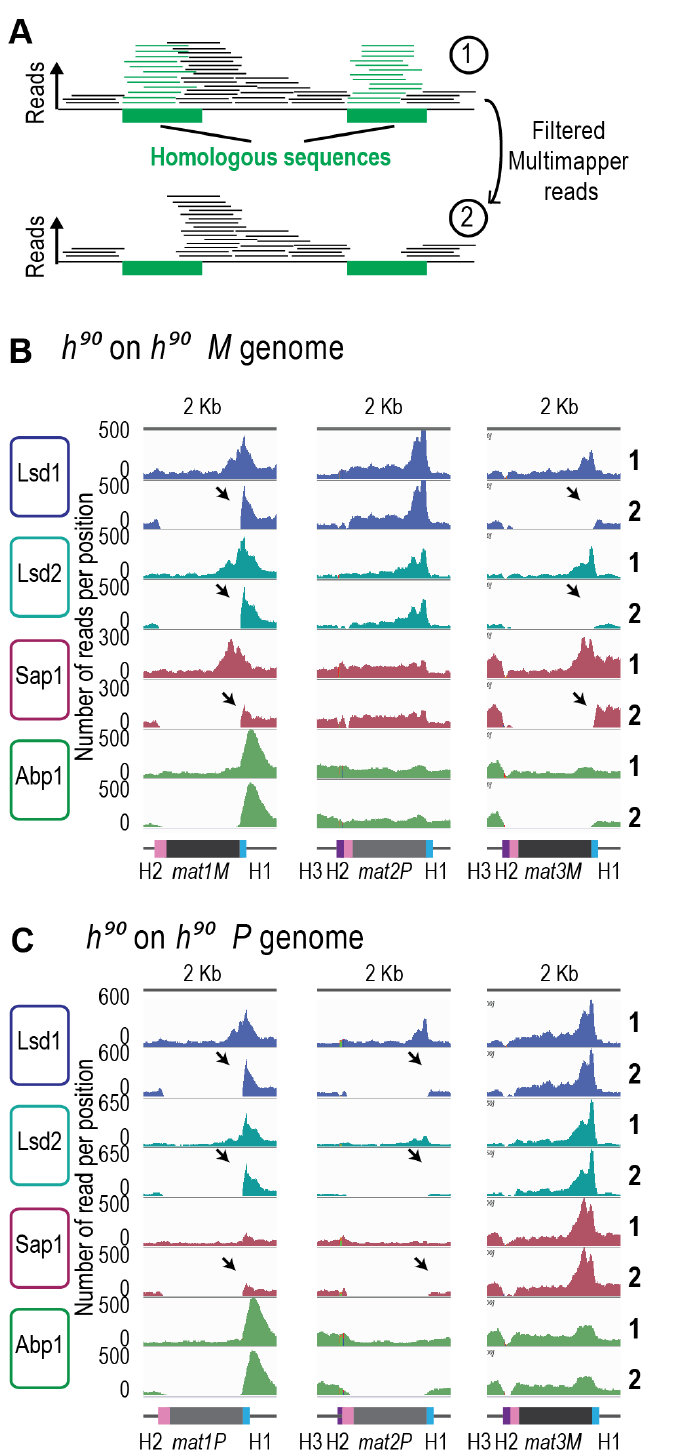
FIGURE 4: Lsd1/2 and Abp1 are recruited only at mat1 . (A) Schematic representation of the analysis used. Green boxes represent homologous sequences. Reads that can be unambiguously mapped are represented by black lines and multi-mapper reads are represented by green lines. Upper drawing represents the result of an align- ment without filter (1). Lower drawing represents the alignment after that multi-mapper reads are removed using "samtools" algorithm (2). (B) Distribution of raw coverage of the Abp1, Lsd1, Lsd2, and Sap1 ChIPs. The sequence used for the alignment is a 44-kb region that contains the MT region with the M allele at mat1 : h 90 M . The lines numbered 1 are the coverage without filter and the lines numbered 2 are the coverage obtained after removal of multi-mapper reads. The arrows indicate the unique-mapper reads at the junction of the mat loci. (C) Same as in (B) with the h 90 P sequence used for the